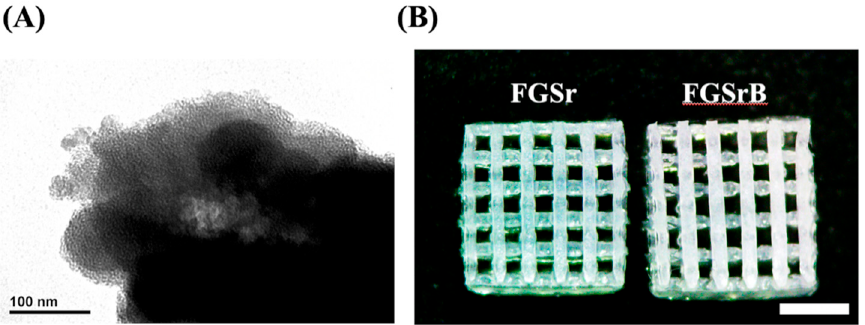
Figure 1. ( A ) TEM micrographs of mesoporous SrCS nanomaterial. ( B ) The top-view photograph of 3D-printed FGSr and FGSrB scaffolds. The scale bar is 2 mm.